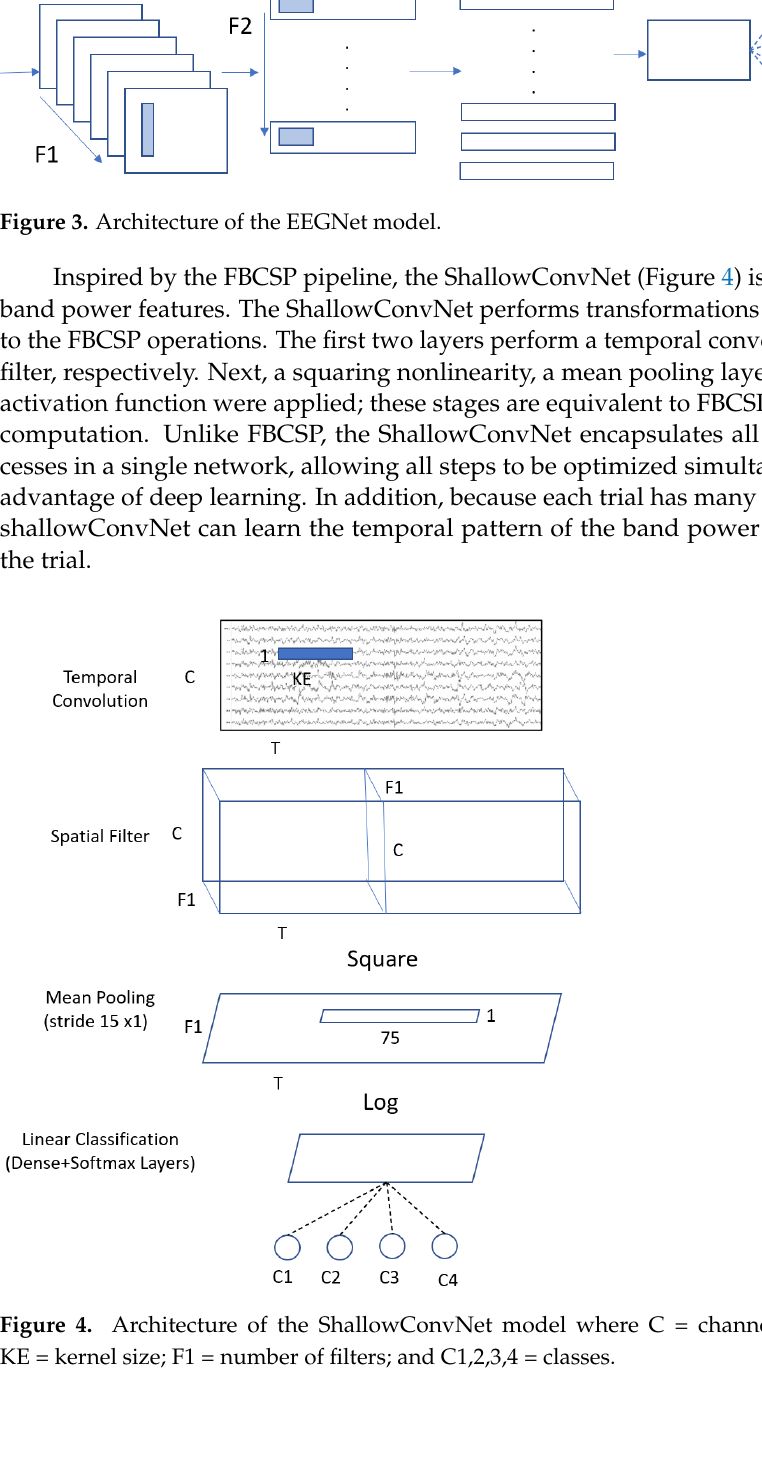
Figure 5. Architectural of MBEEGNet model (F1 = number of filters in temporal convolution, KE = kernel size in temporal convolution, Pe = dropout probability).